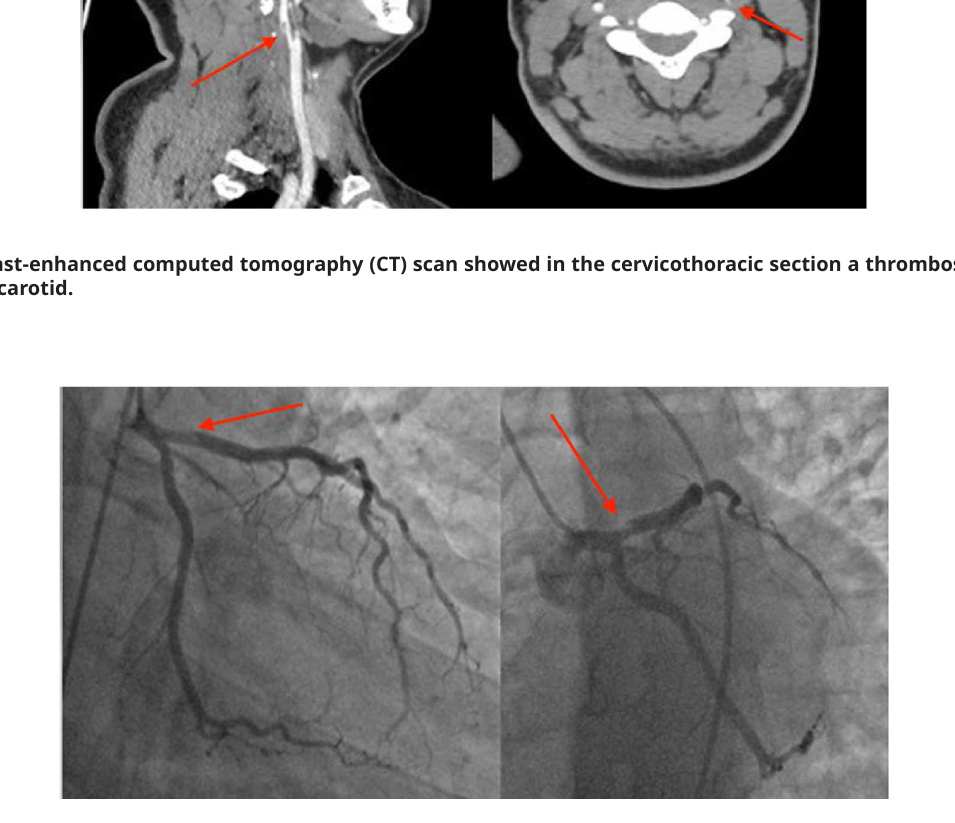
At 3-month clinical control check-up, he retained right lower limb motor sequelae. Cardiac control showed the absence of symp- toms, with a good electrocardiographic and echocardiographic evolution (LVEF: